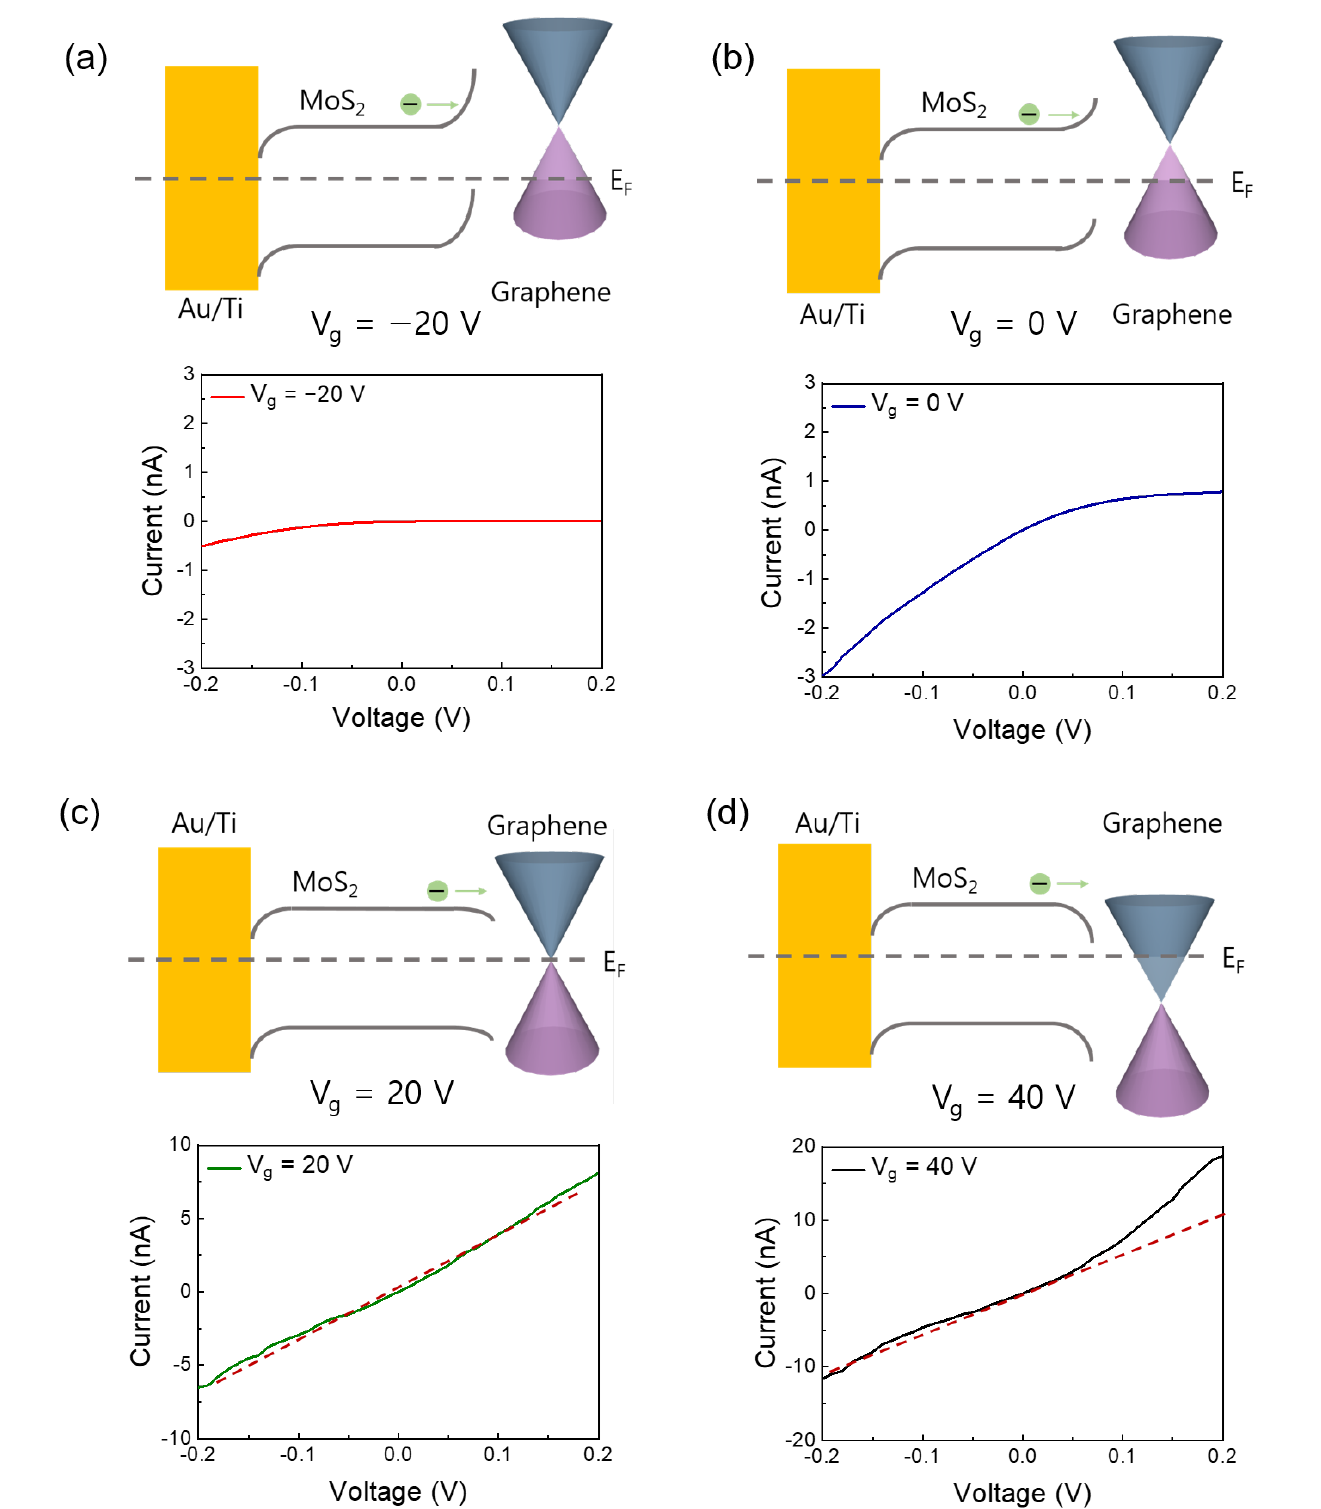
Figure 4. Band diagrams and electrical properties of the MoS 2 FET with Au–graphene heteroelectrode at different gate voltages (( a ) − 20 V, ( b ) 0 V, ( c ) 20 V, and ( d ) 40 V).